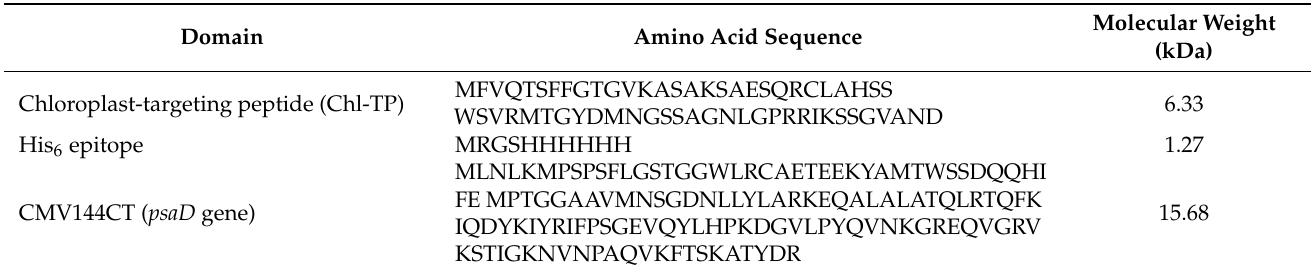
Table 1. Amino acid sequence of the His 6 -PsaD pre–pro-protein subjected to post-translation processing. Domain Amino Acid